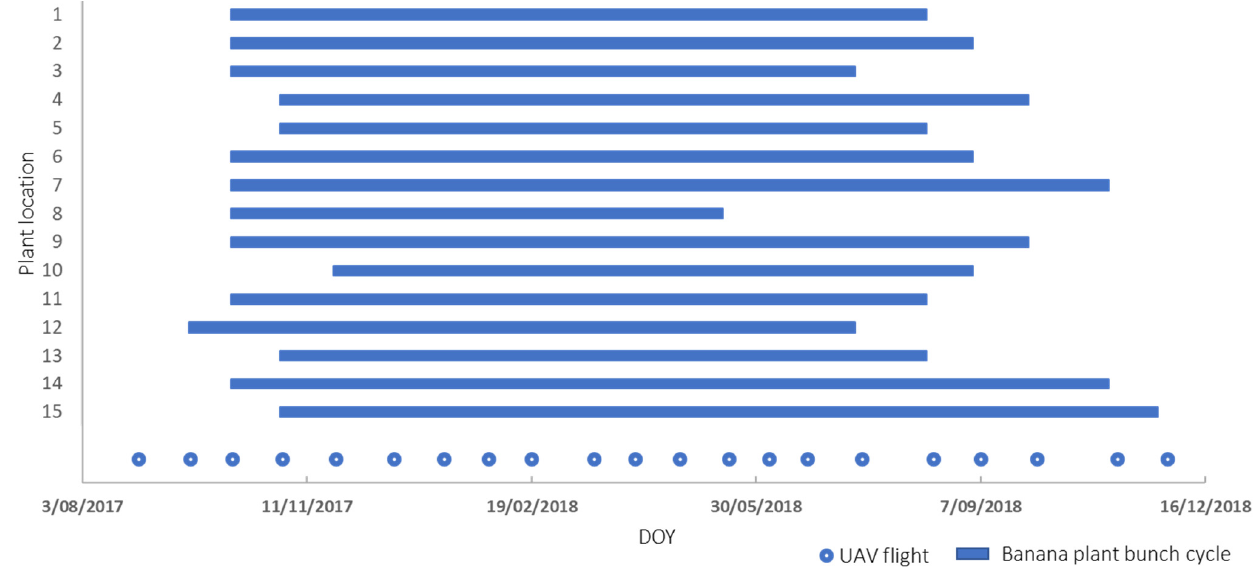
Figure 3. Timeline illustrating the flight campaign data collection frequency and dates at the study site in relation to the asynchronous growth of each of the 15 selected banana plants measured in the field, with each bar indicating the commencement of growth (H event) to harvest (H1 event).